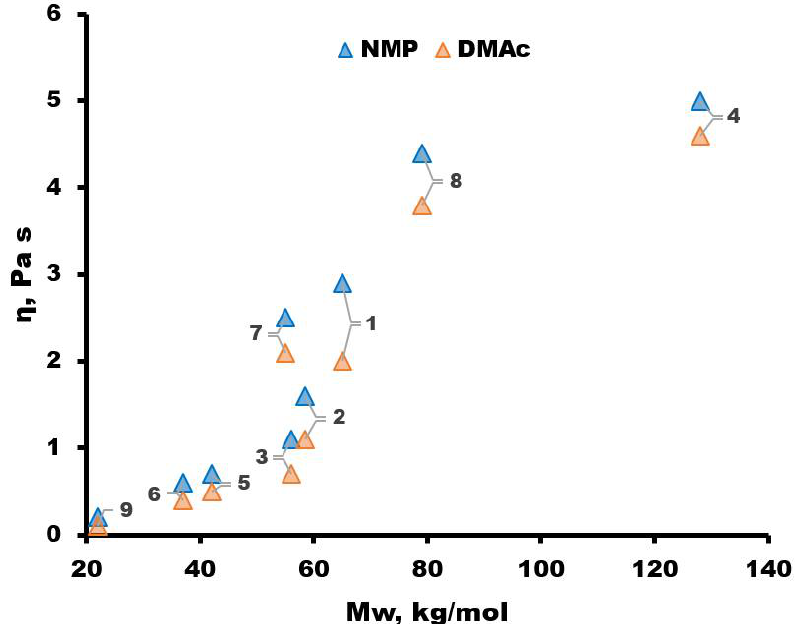
Figure 5. Dependence of the dynamic viscosity of the PSF/NMP and PSF/DMAc solutions on the molecular weight of PSF. The sample numbers are the same as those in Table 3.